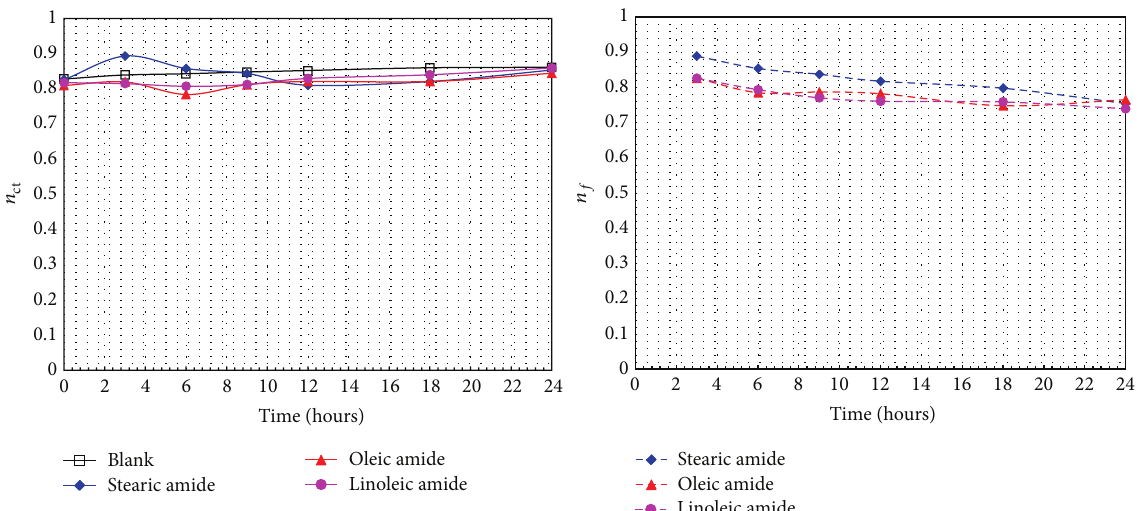
Figure 12: 𝑛 and 𝑛 𝑓 variation against time for carbon steel with and without ct